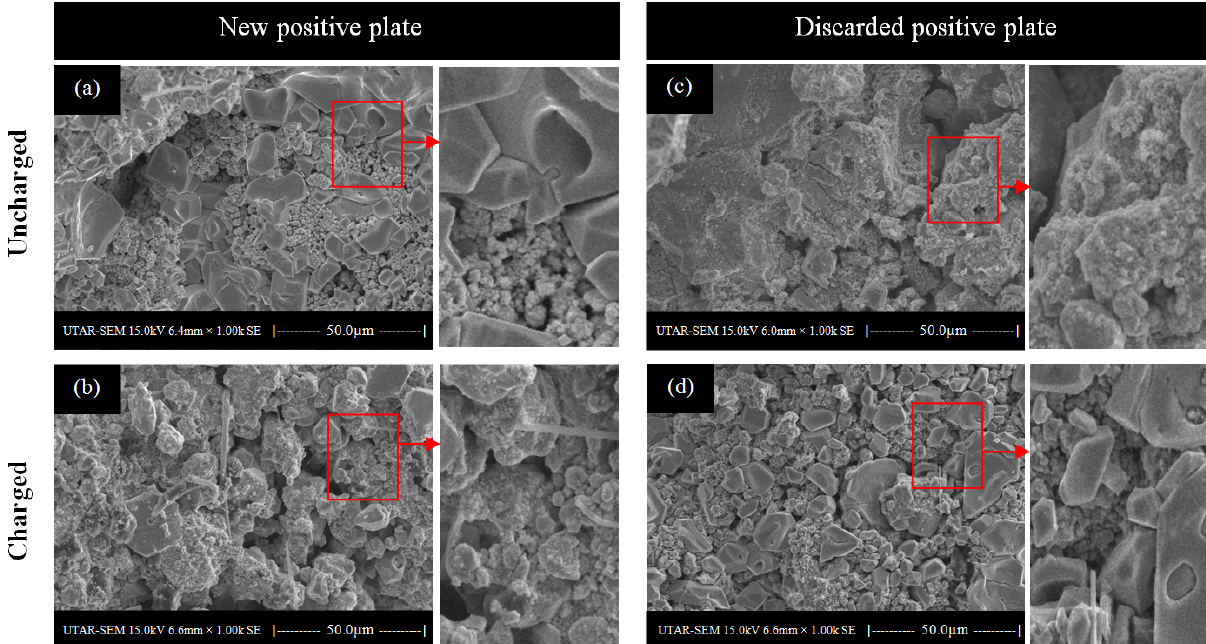
Figure 3. Microscopic scans of new positive plates ( a , b ), and discarded positive plates ( c , d ) before and after charging at 2.4 V.